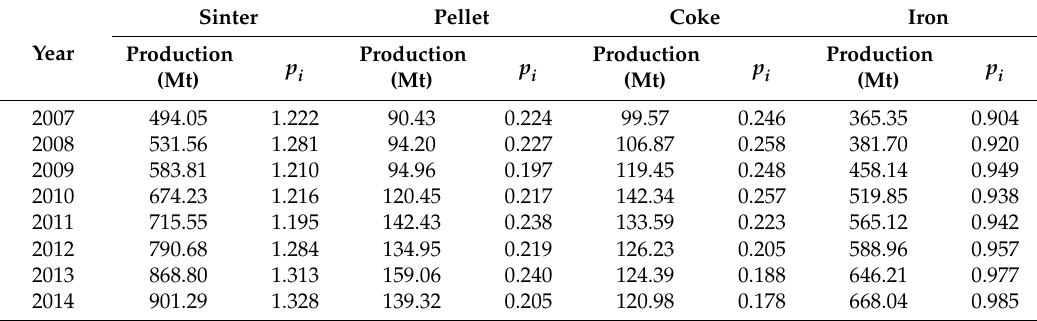
Table 3. Process energy consumption of China’s key steel enterprises from 2007 to 2014 [21,32,33]. Sintering Pelletizing Coking Blast Furnace BOF EAF Rolling Year (kgce/t Sinter) (kgce/t Pellet) (kgce/t Coke) (kgce/t Iron) (kgce/t Steel) (kgce/t Steel) (kgce/t Product)